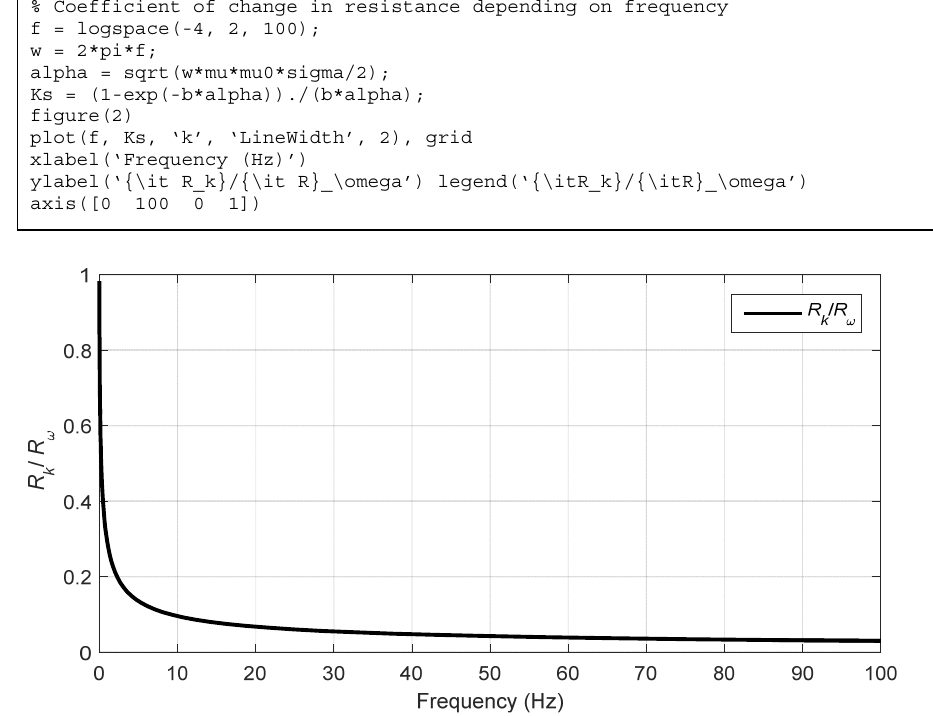
Figure 8. The coefficient of change in resistance of eddy currents’ fictitious element due to the skin effect depending on frequency f (in Hz) in a 5 cm thick solid steel core.